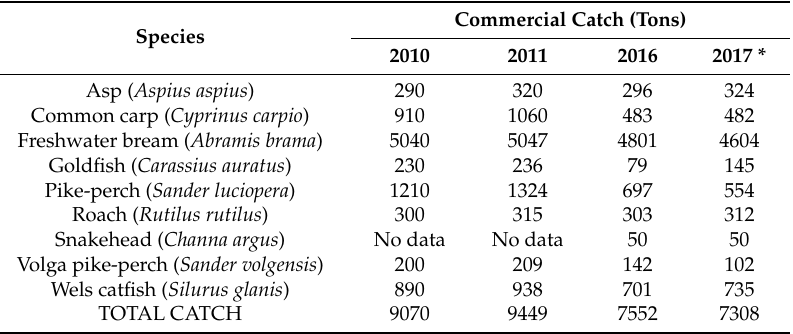
Table 4. Commercial fish capture from Lake Balkhash during the second decade of the 21st century. * data are estimates for the year. (Sources: Data are from the Kazakh Research Institute of Fishery; for fish names, see: FishBase.org).